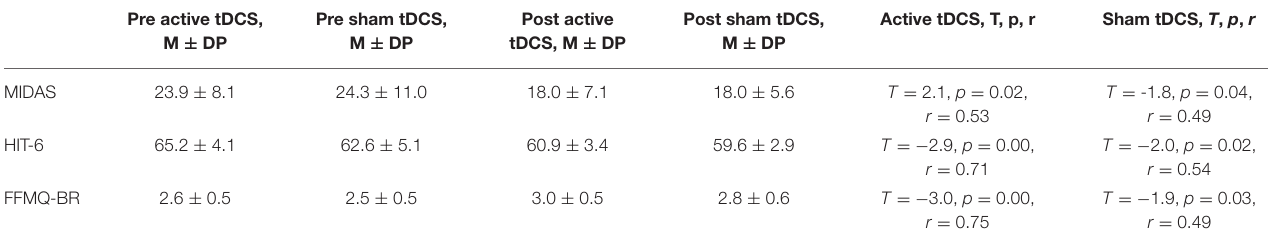
TABLE 4 | Active tDCS vs. sham tDCS intragroup comparison associated with mindfulness of the three clinical outcomes in pre and post treatment. Pre active tDCS, M ±